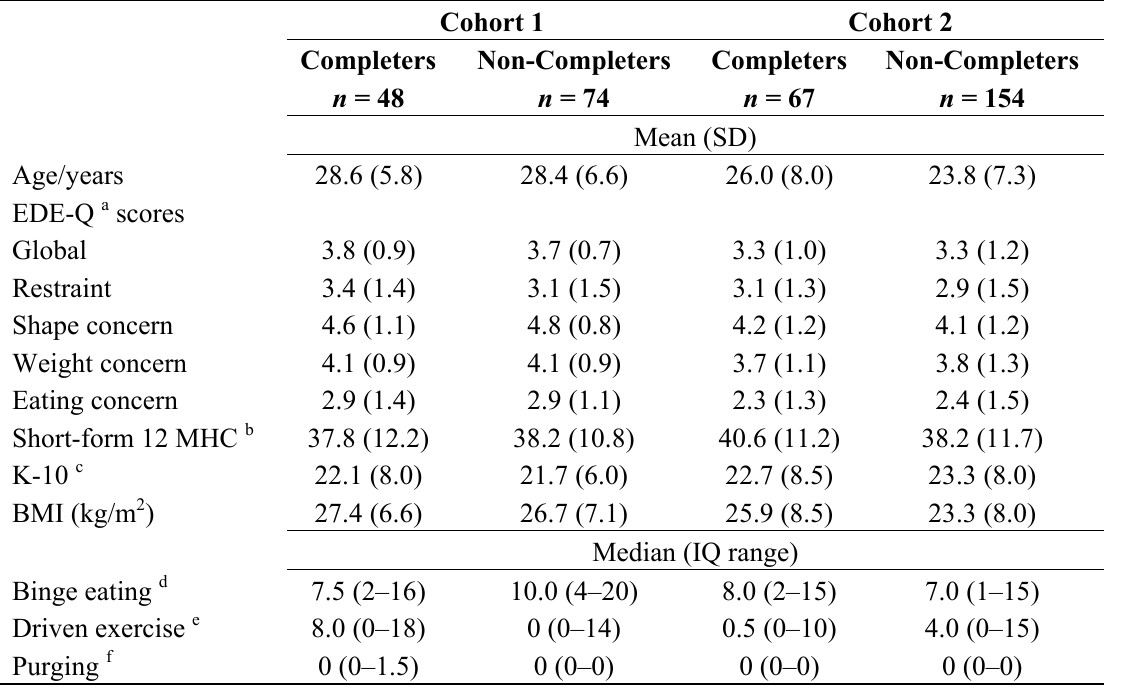
Table 1. Comparative baseline features (mean (SD) or median (IQR)) of those who completed each of the 5 years of follow-up and those who did